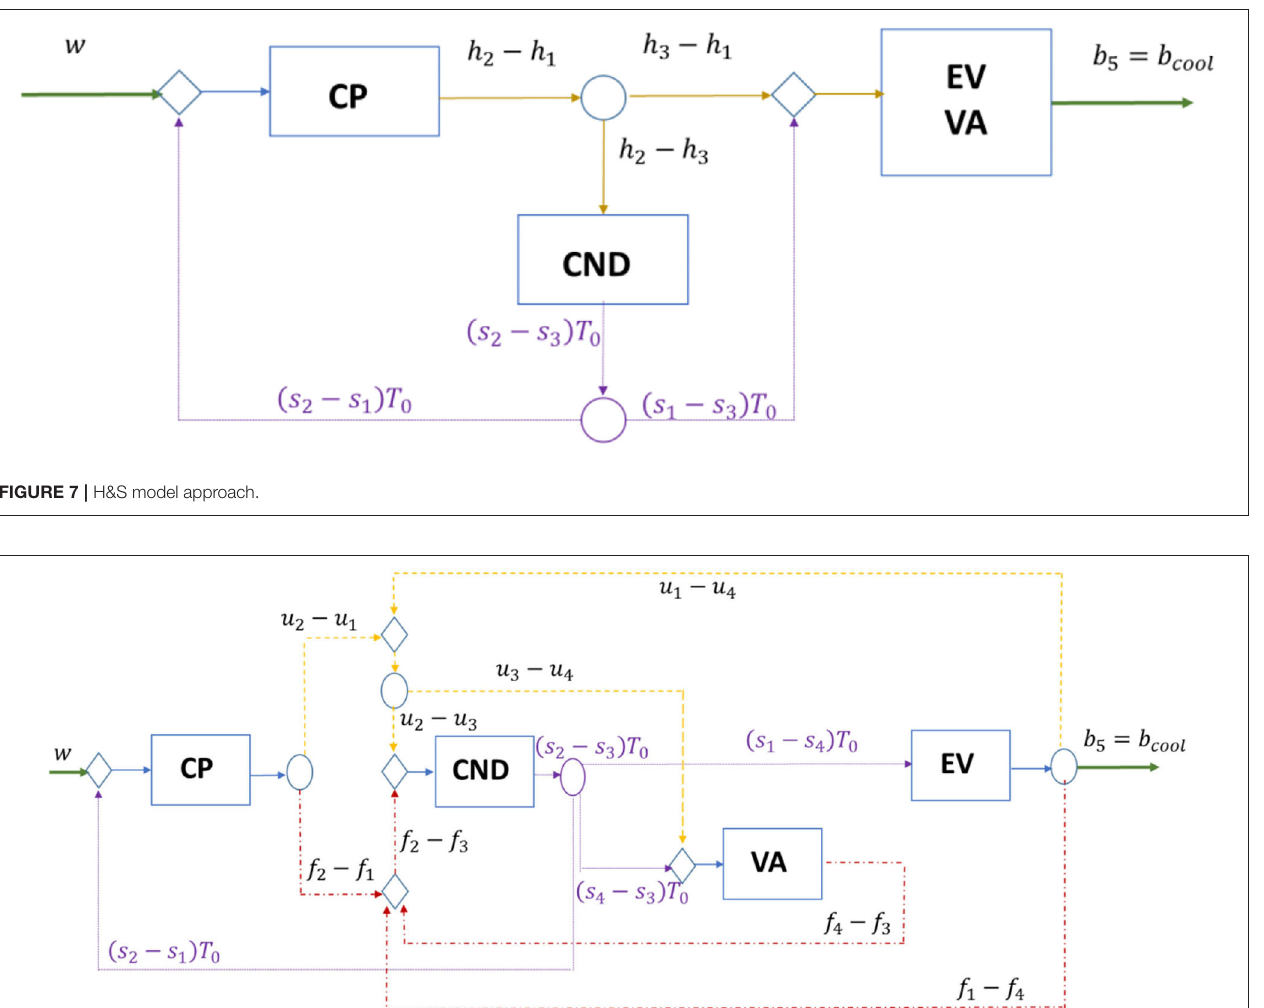
FIGURE 8 | UFS Model.